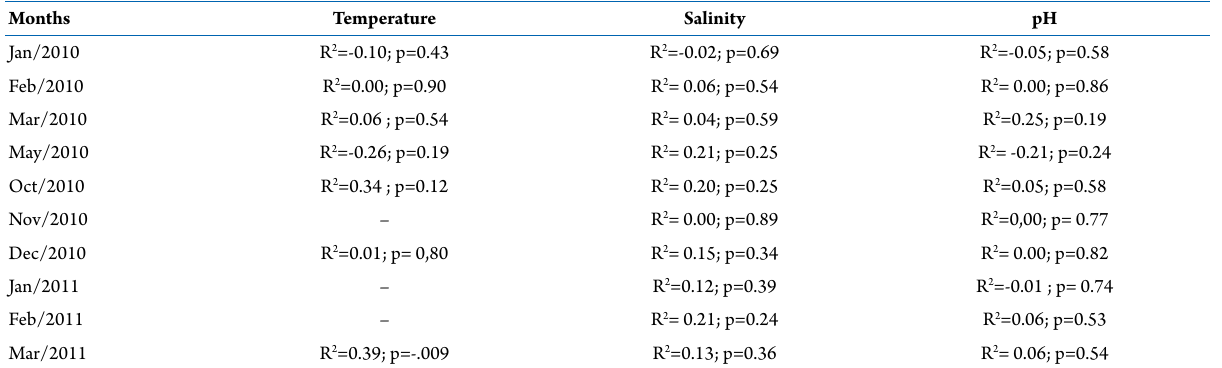
Table 2. Spatial variation correlations between abiotic data (Temperature, Salinity, and pH) and Acartia tonsa over the sampled months.